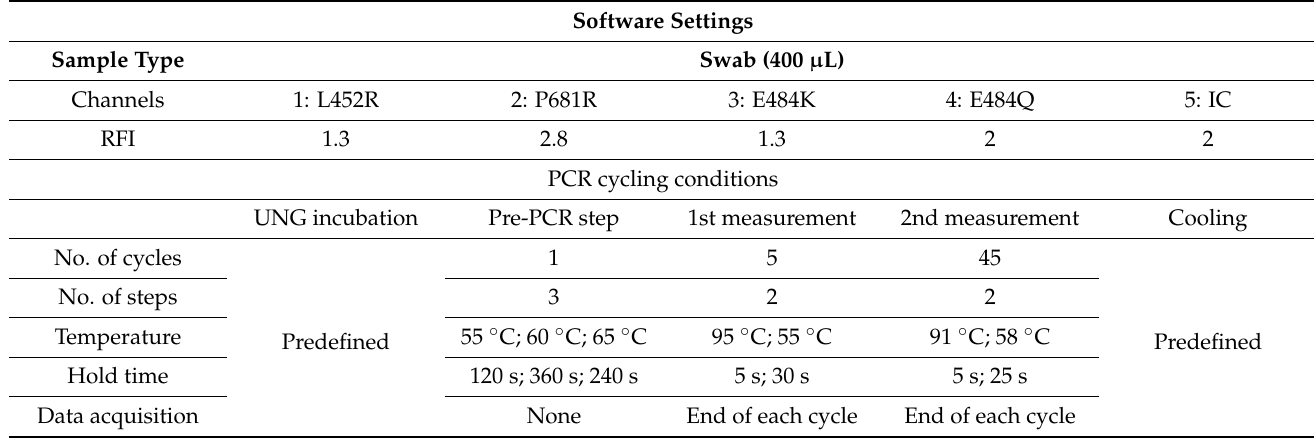
Table 2. Run protocol for the SCOV2-617VOC-UCT assay, configured with cobas omni Utility Channel software (Roche Diagnostics, Basel, Switzerland). Material type was Swab, 400 µ L sample input volume. RFI (relative fluorescence increase) is used as threshold for automatic result